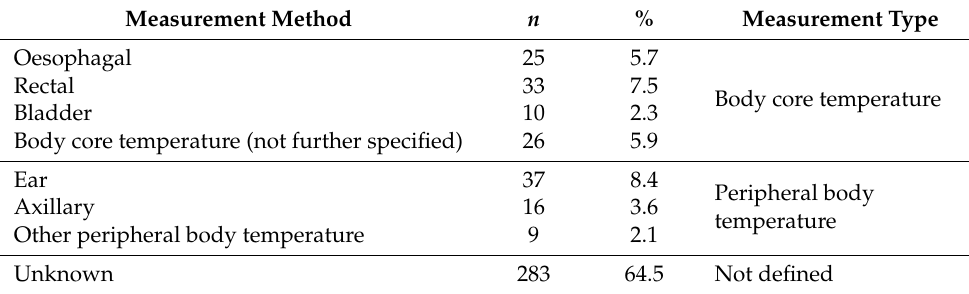
Table 2. Methods of measuring